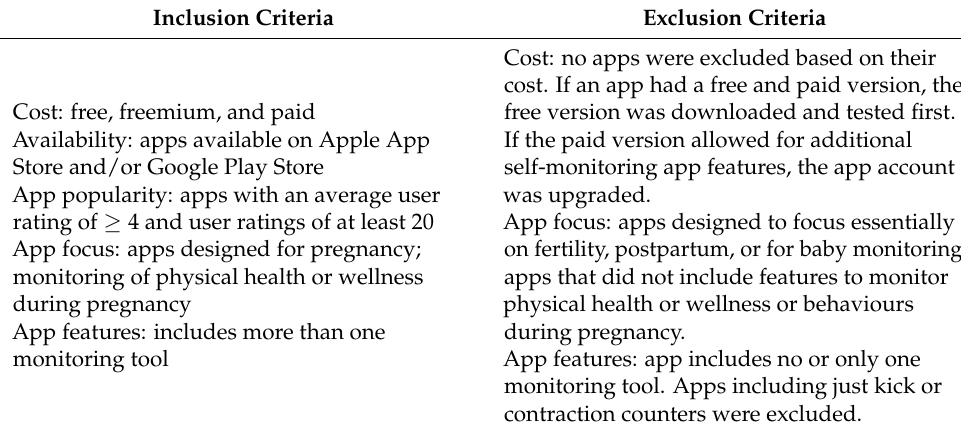
Table 1. App inclusion and exclusion criteria. Inclusion